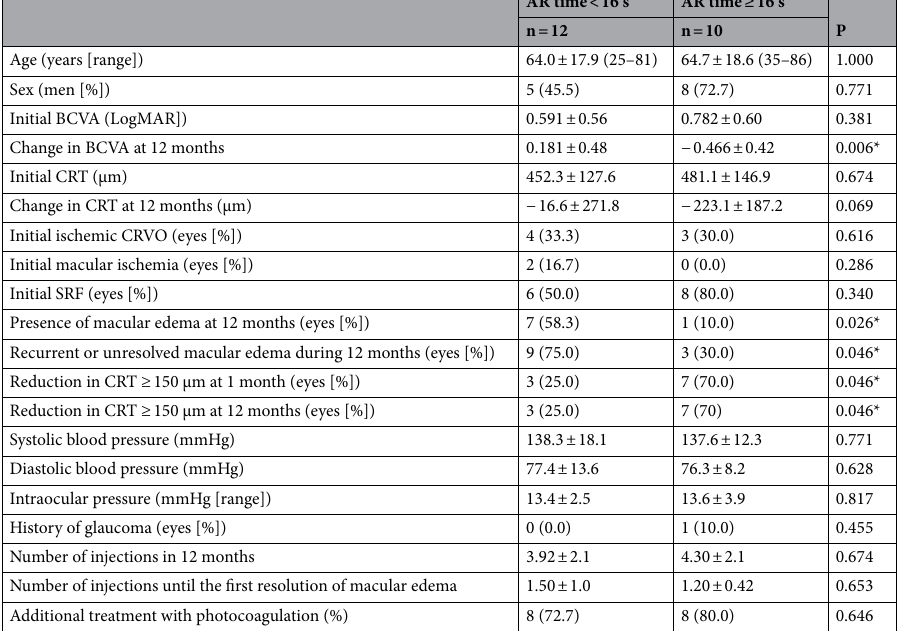
Table 3. Comparison of the AR time < 16 s and AR time ≥ 16 s groups. Data are represented as the mean ± SD. The Mann–Whitney U test or Fishers’ exact test (one-sided) were used for comparison. AR time arm-to-retina time, BCVA best-corrected visual acuity, CRT central retinal thickness, CRVO central retinal vein occlusion, SRF subretinal fluid. *P <